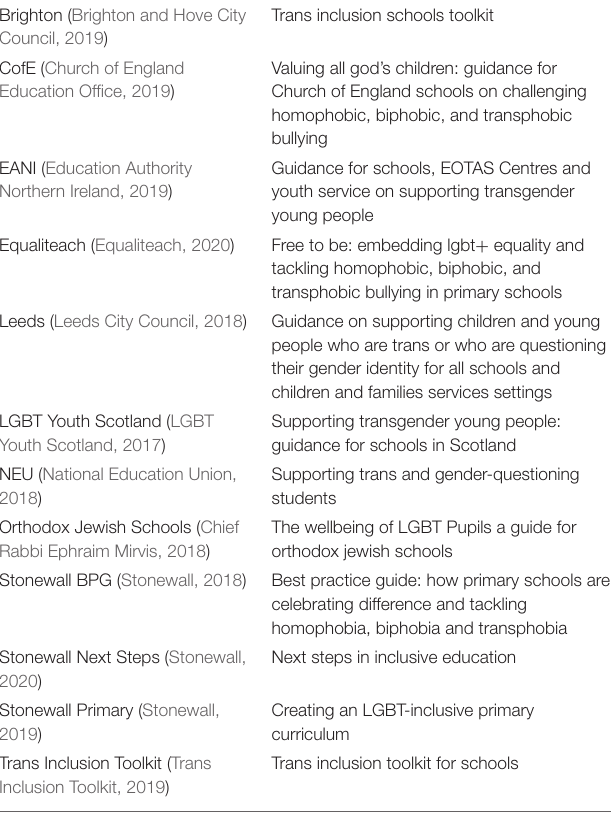
TABLE 1 | List of trans-inclusion school